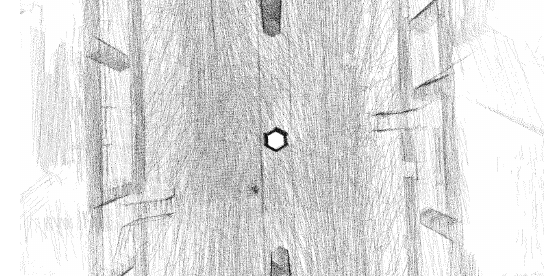
Figure 7. Map generated by the SLAM approach for the metro station dataset using an appropriate timestamp offset of 24 ms. Sharp edges indicate a great clarity for this point cloud.